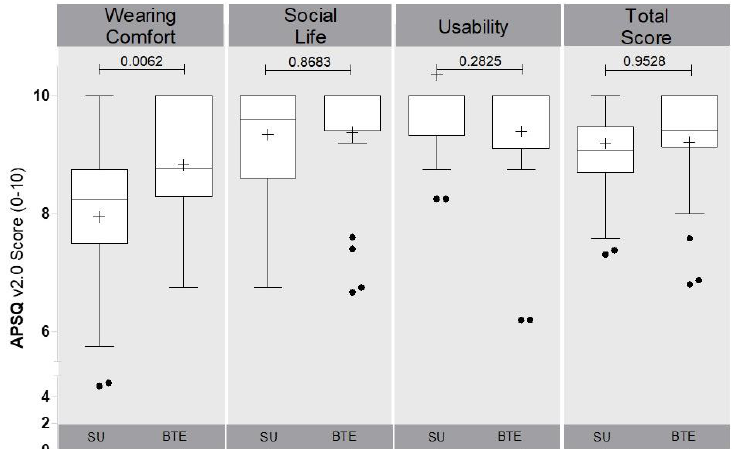
the ear (BTE)) are displayed in Figure 3.